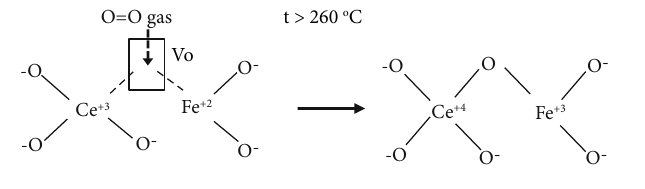
Figure 8: The mechanisms of CO oxidation and the oxidation state conversion of metal ions between Ce +4 /Ce +3 and Fe +3 /Fe +2 pairs on the CeO -Fe O catalyst surface. 2 2 3